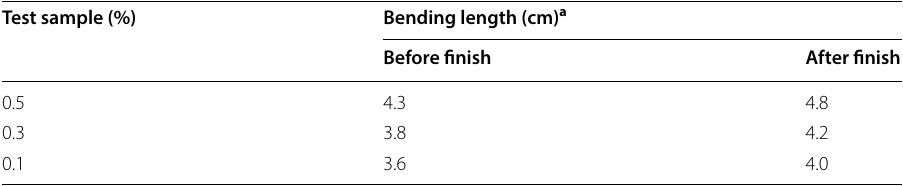
a Bending length of control sample: 3.4